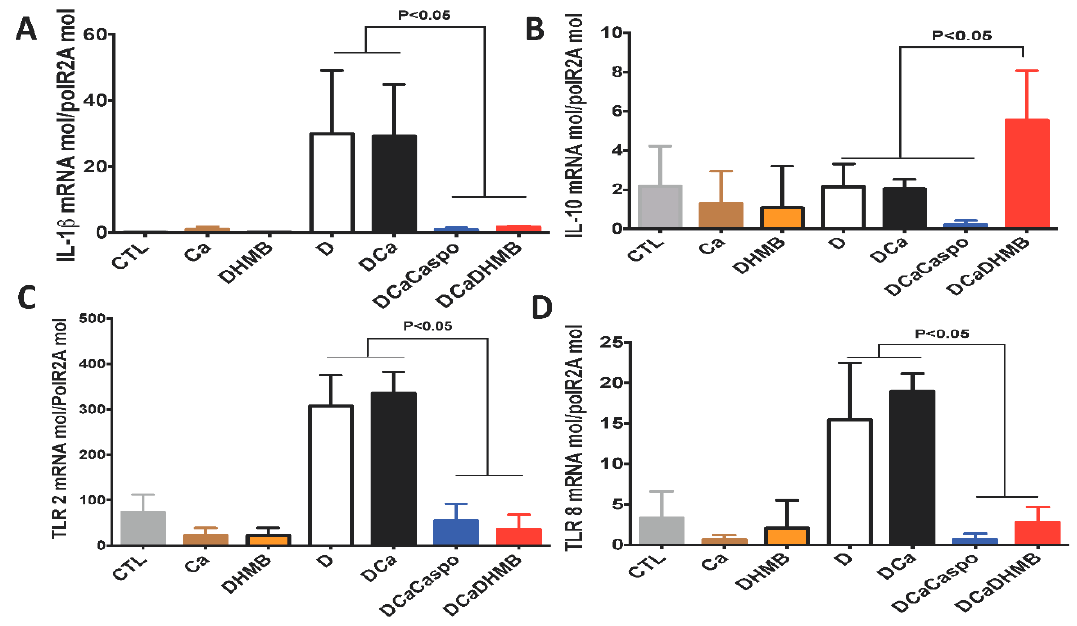
Figure 8. Cytokine and receptor expression after DHMB treatment. ( A – D ) Relative expression levels of IL-1b, IL-10, TLR-2 and TLR-8 mRNA in mouse colons. Data are the mean ± SD of 10 mice per group from two independent experiments.